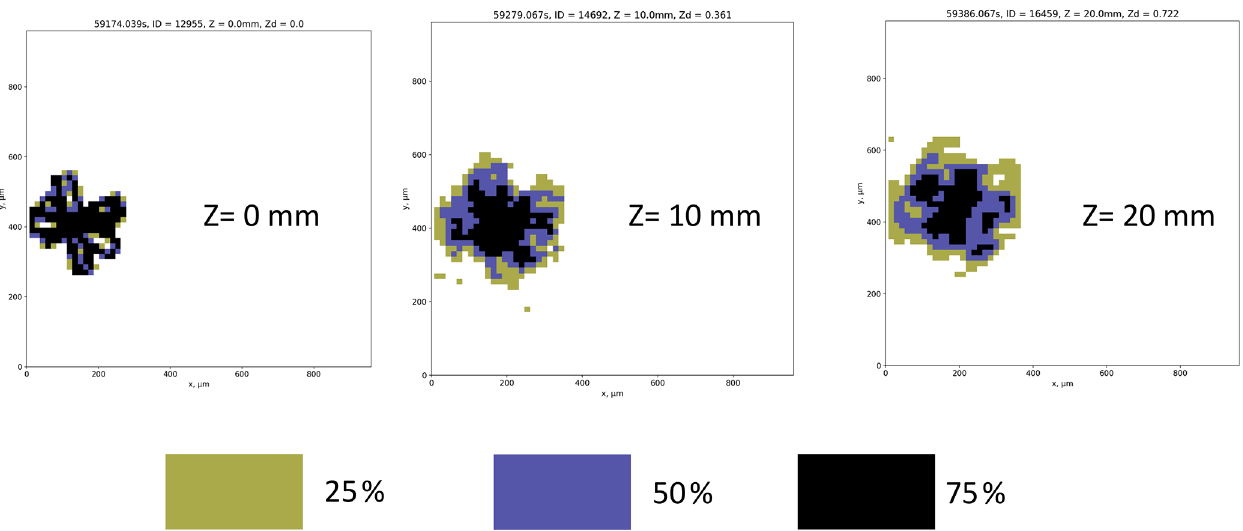
Figure 8. CIP-15 images of the ice crystal analogue ROS300 at three distances from the object plane.